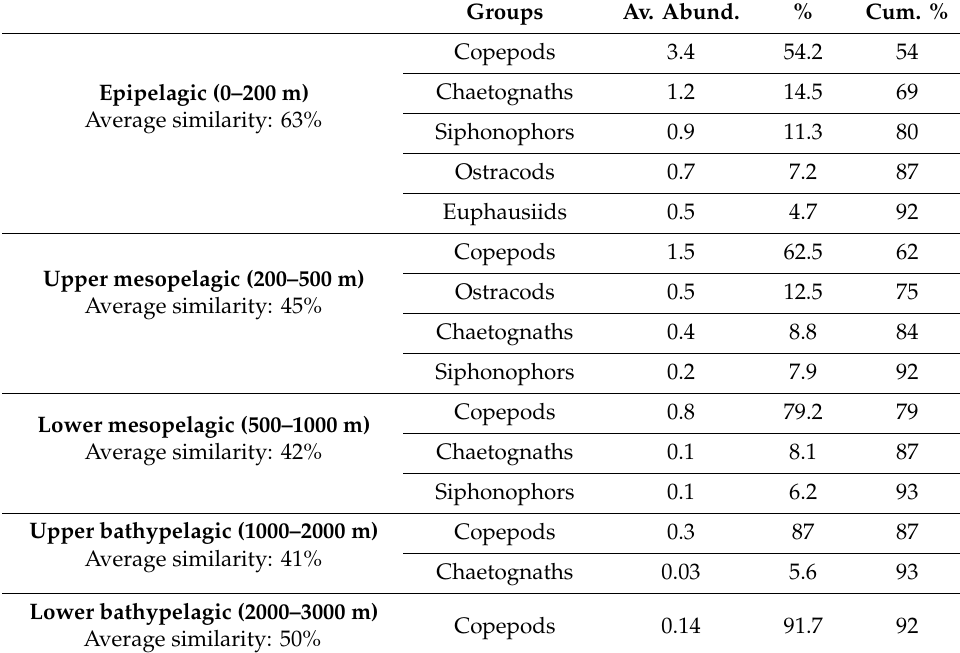
Table 2. Contribution of main zooplankton groups at the di ff erent strata (Simper analysis). Av. Abund. stands for Average Abundance (ind · m − 3